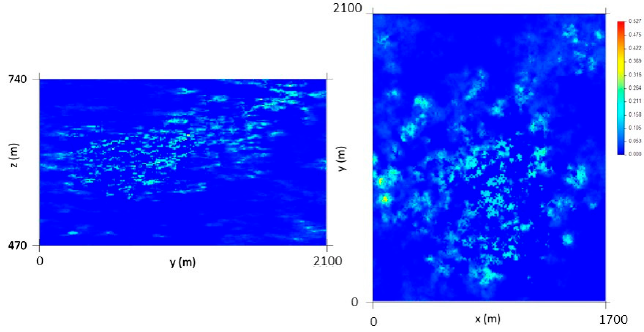
Figure 7. DSS second-phase results: Px81 (left) and Pz75 (right). The diagrams show one of 1000 scenarios.